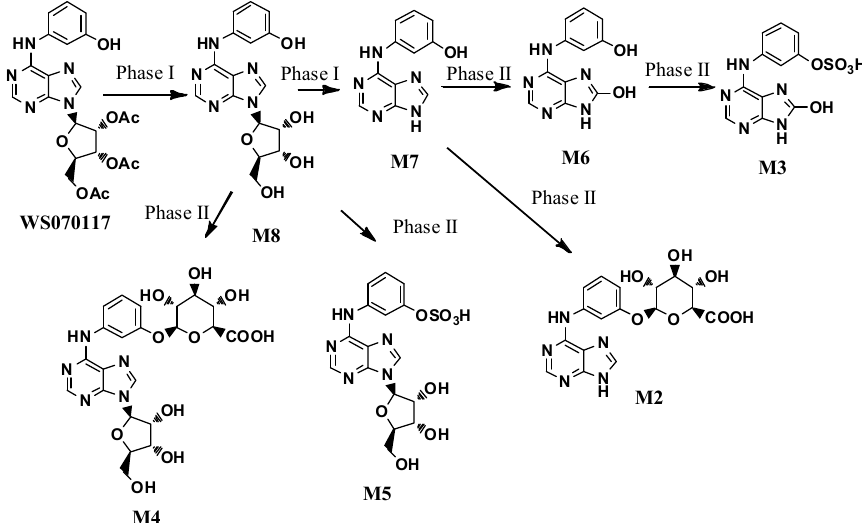
Figure 1. The structures of the WS070117 metabolites in rat urine.